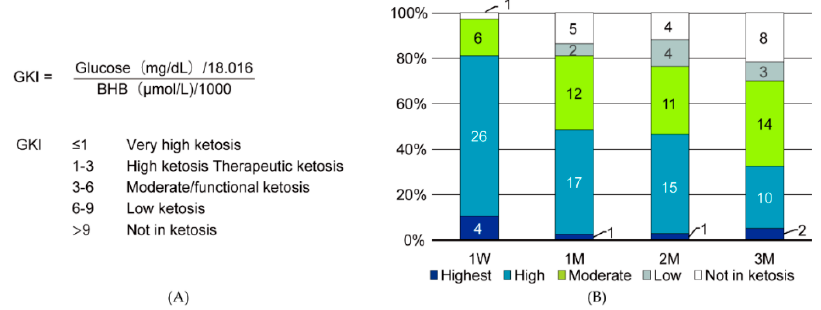
Figure 3. ( A ) Glucose ketone index (GKI) and ( B ) the GKI after the ketogenic diet.